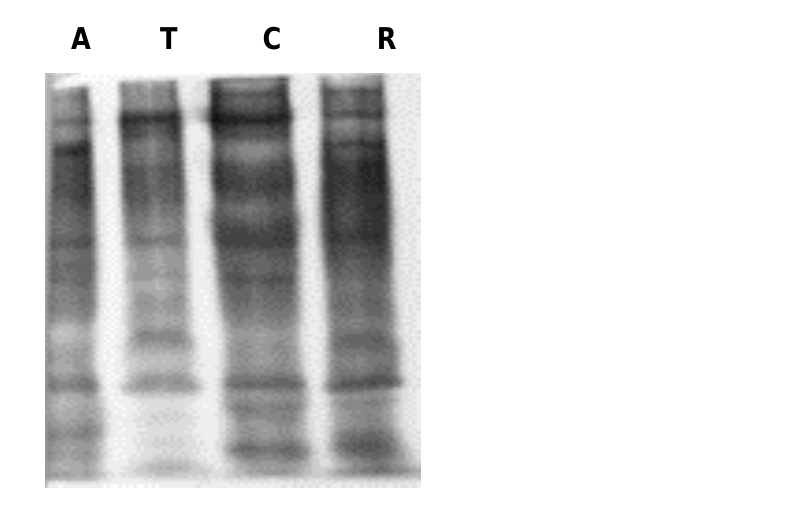
Figure 2: Western blots of separated protein bands of all four scorpion venom samples.